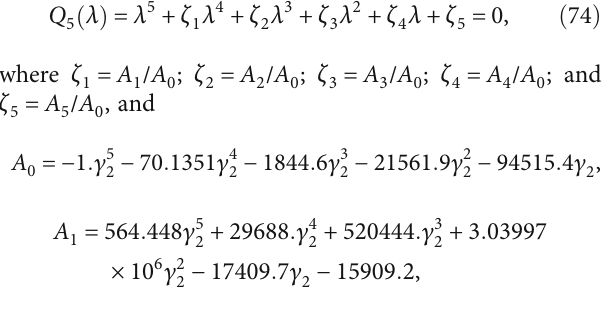
/ d γ 2 Þ 2 for model system (1) with assumed